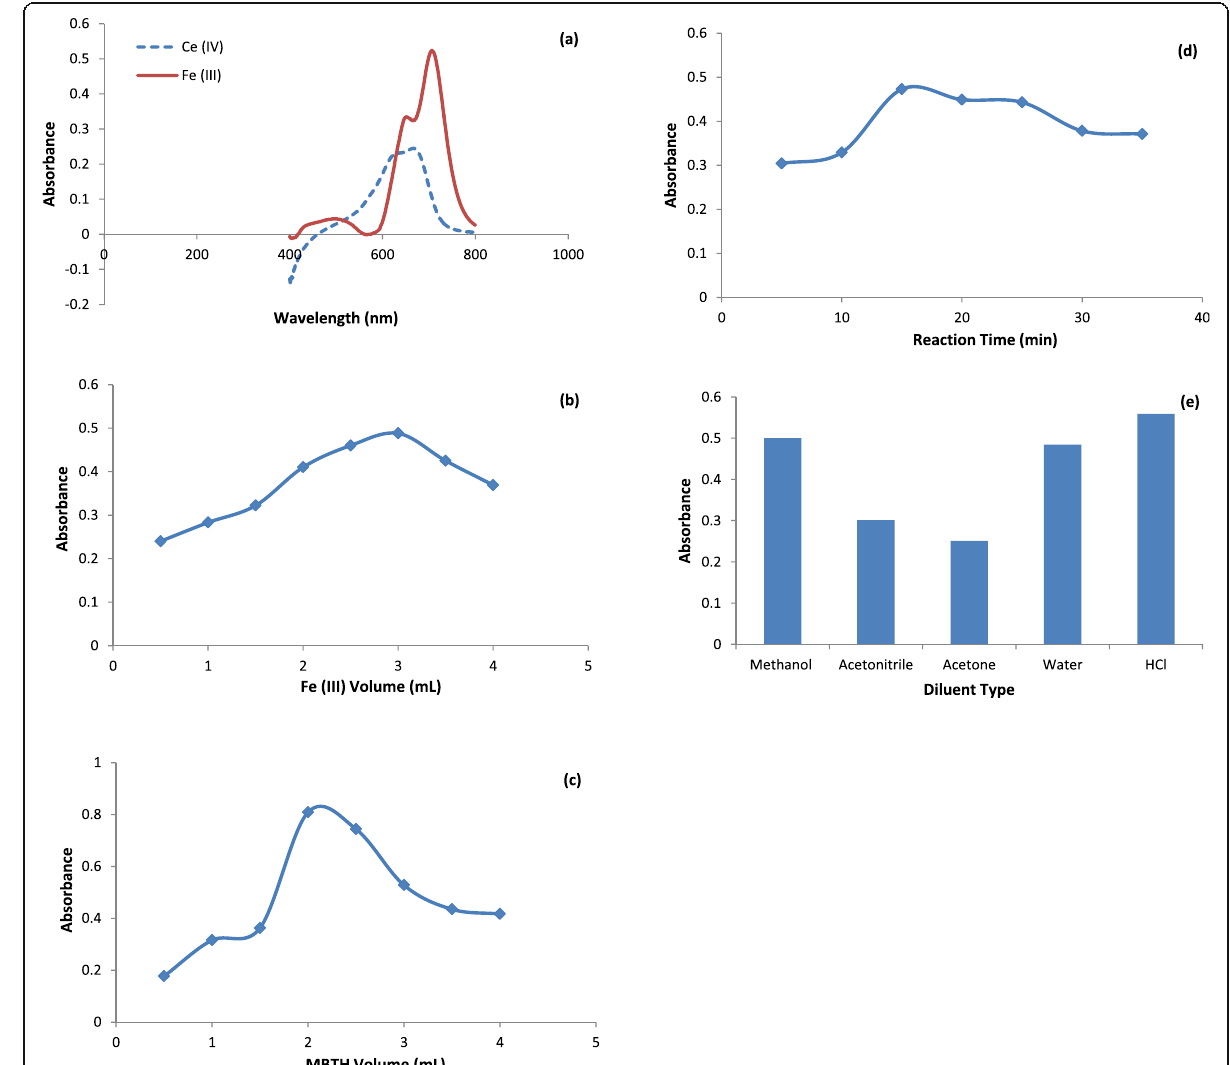
Fig. 7 a Absorption spectra of the reaction product of VP with 0.01 M MBTH using 1% w/v Fe(III) chloride and Ce (IV) sulfate, b the effect of 1% w/v Fe(III) volume on the absorbance of the reaction product using VP (50 μ g/mL), c effect of 0.01 M MBTH volume on the absorbance of the reaction product using VP (50 μ g/mL), d effect of reaction time on the absorbance of the reaction product using VP (50 μ g/mL) in presence of 0.01 M MBTH and 1% w/v Fe(III), e effect of diluting solvent on the absorbance of the reaction product using VP (50 μ g/mL) in presence of 0.01 M MBTH and 1% w/v